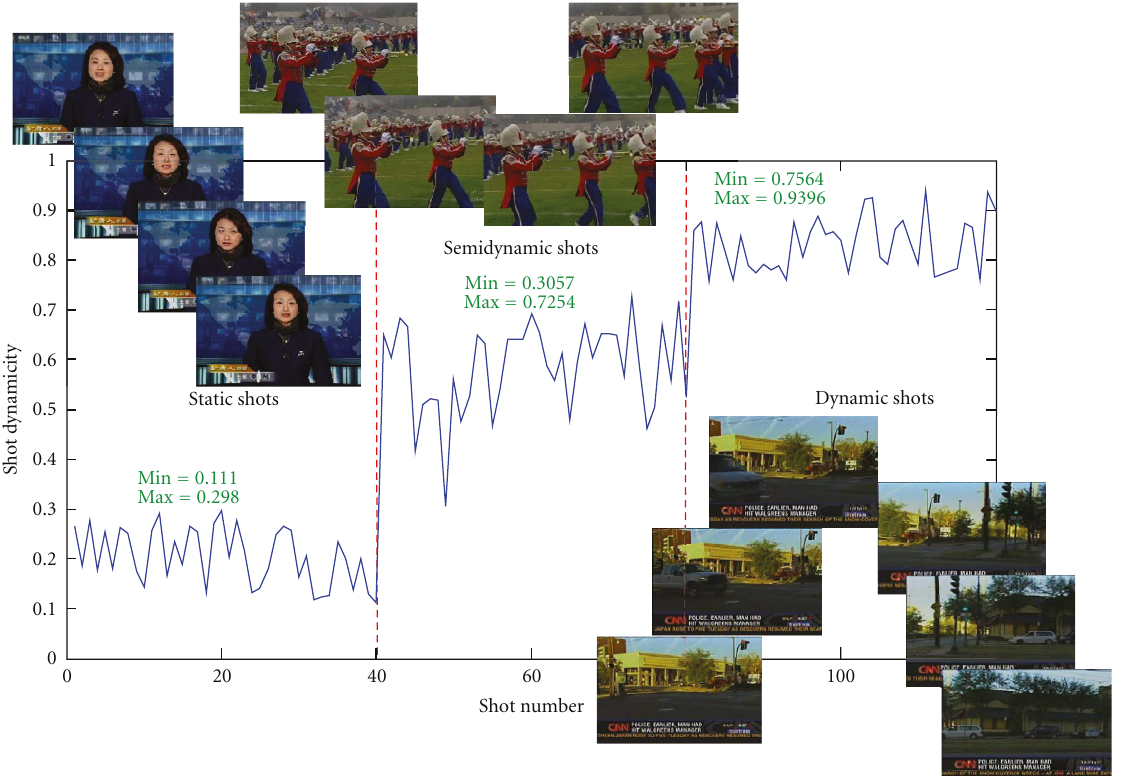
Figure 2: Three categories of the video shots based on shot dynamicity measure: static, semidynamic, and dynamic.